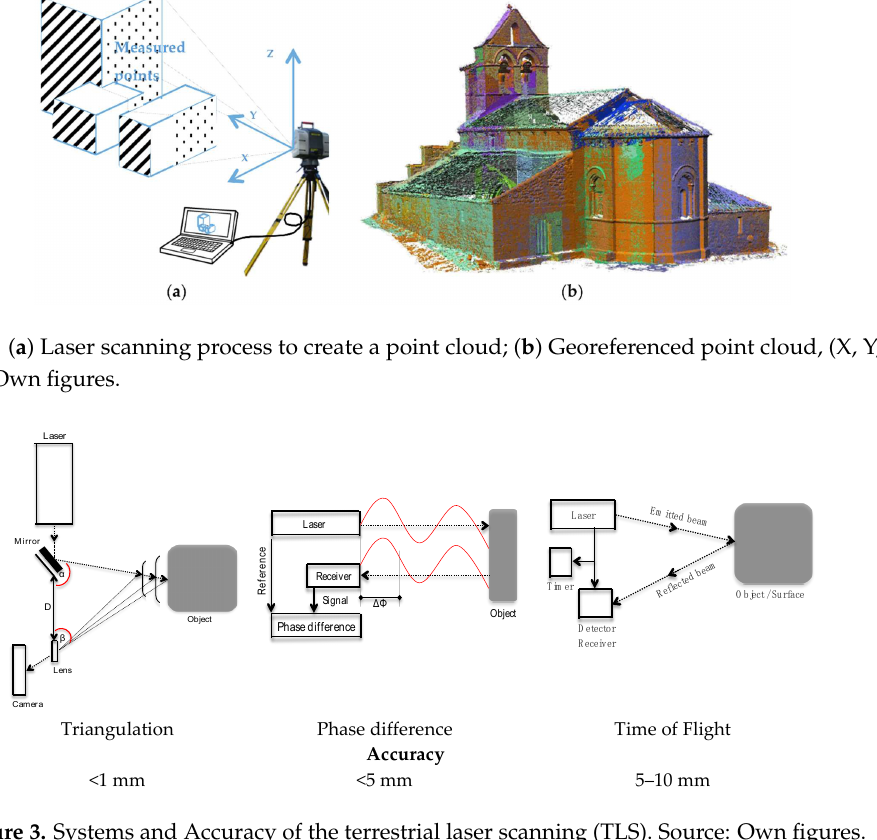
Figure 3. Systems and Accuracy of the terrestrial laser scanning (TLS). Source: Own figures.